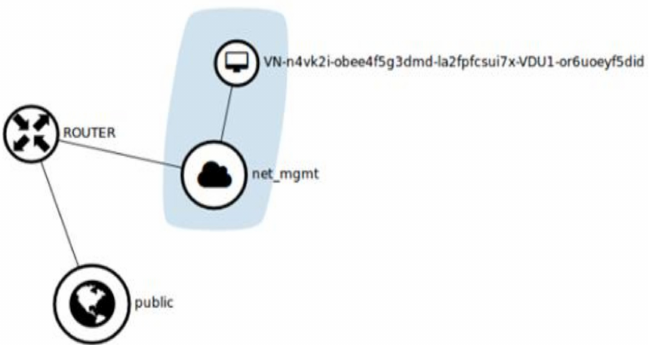
Figure 9. Network Topology after deployment of VNF in a cloud